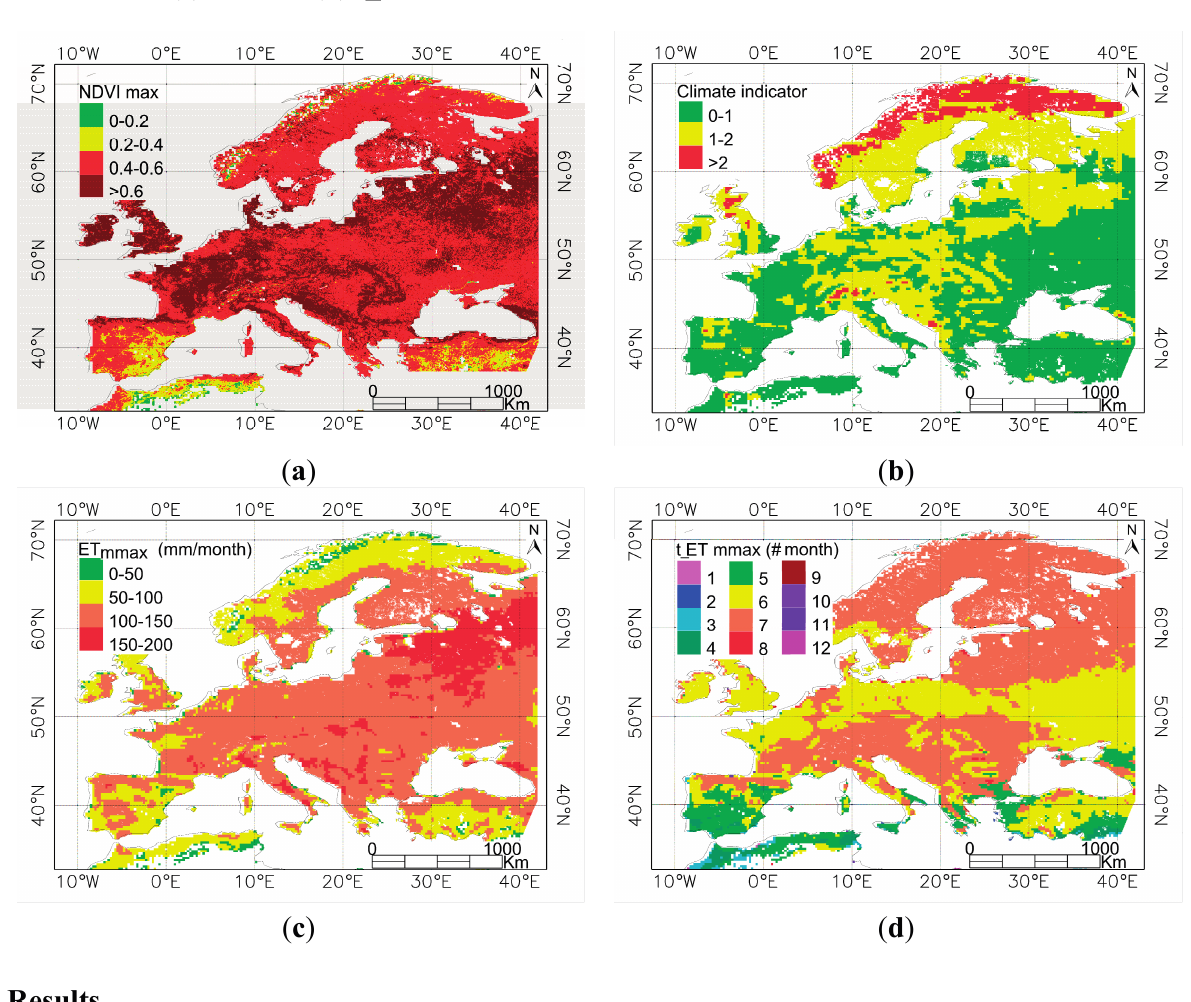
Figure 2. Study area and inputs used in the present paper: ( a ) NDVI ; ( d ) t_ET indicator; ( c ) ET mmax mmax